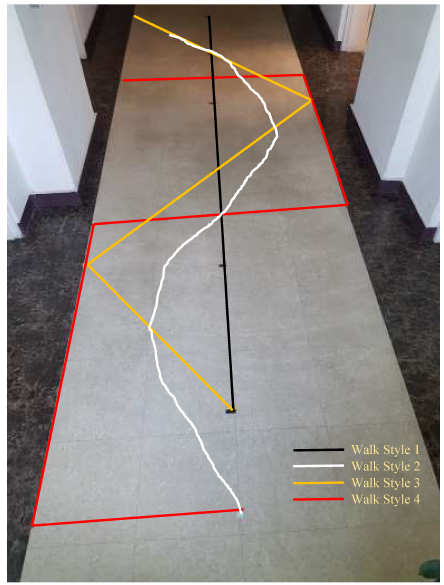
Figure 15. The walking styles used for experiment.